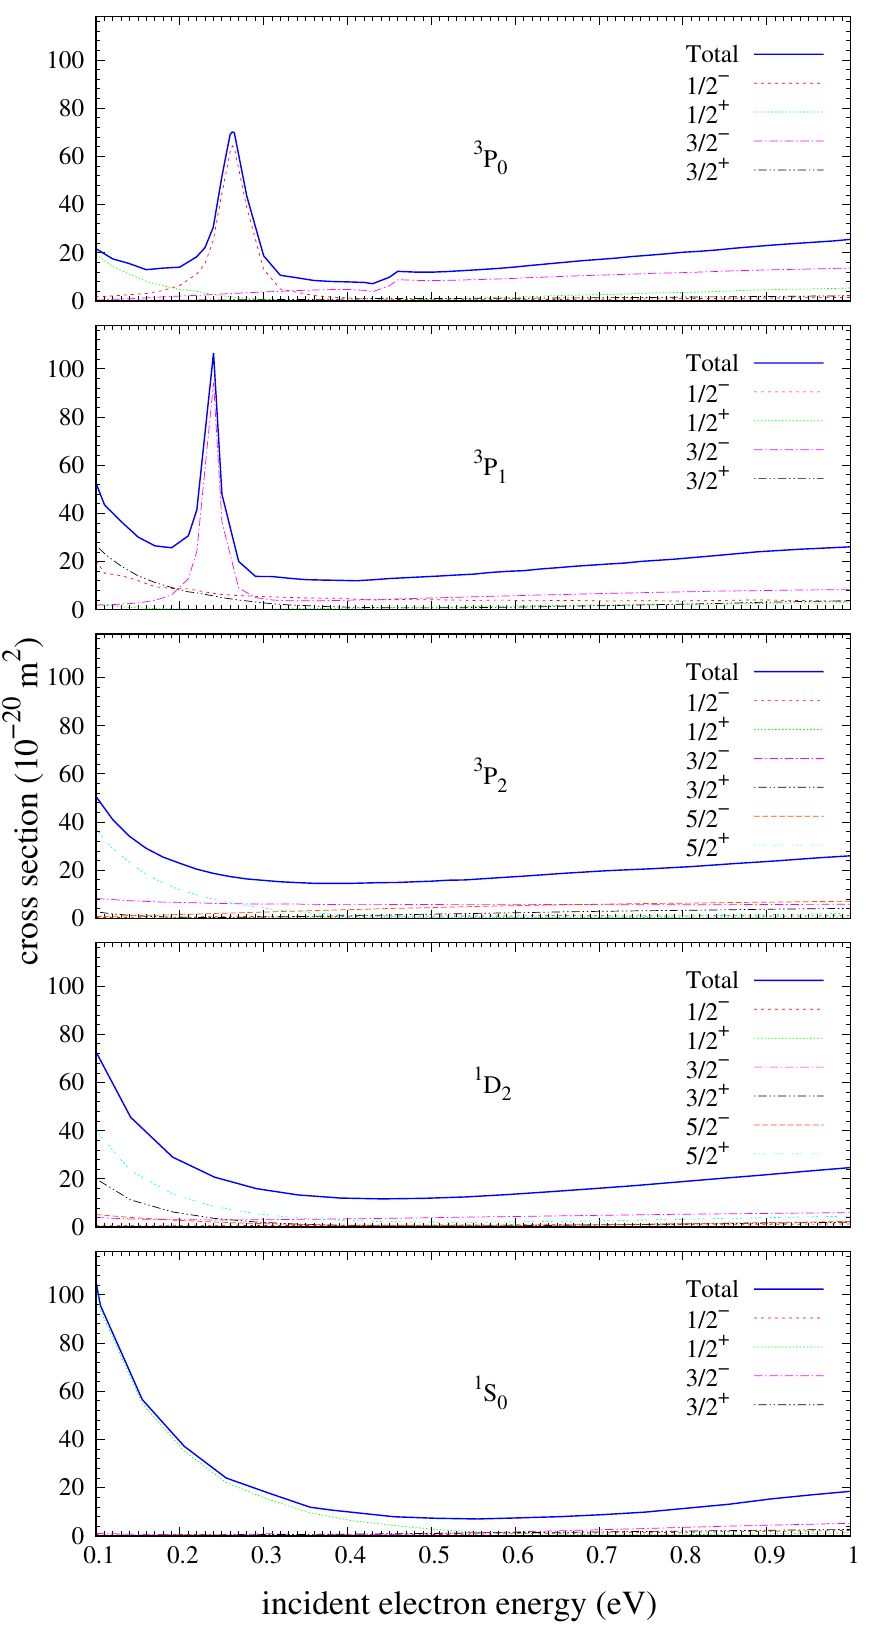
Figure 2. RCCC results for elastic scattering on the ground and first four excited states of atomic tin in the low-energy regime, presented with a partial-wave decomposition. The electron configuration for these states is 5 p 2